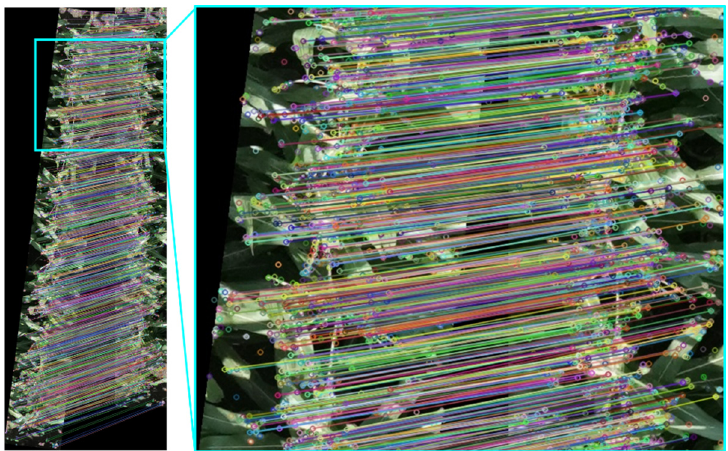
Figure 14. An example of scale-invariant feature transform (SIFT) matchings between the original frame image ( left ) and orthophoto ( right ) for a given row segment.